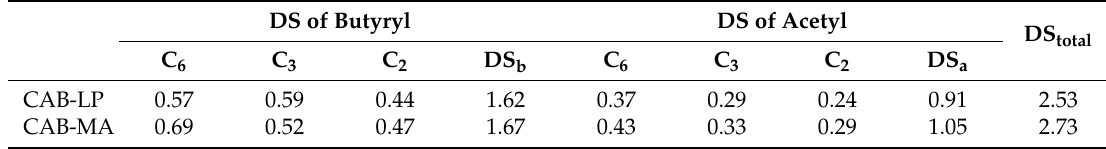
Figure 1. 13 C NMR spectra of cellulose acetate butyrate by mechanical activation (CAB-MA) and liquid phase methods (CAB-LP). Table 1. The distribution of substituted groups in the anhydroglucose unit (AGU) of CAB-MA and CAB-LP. DS: degree of substitution.